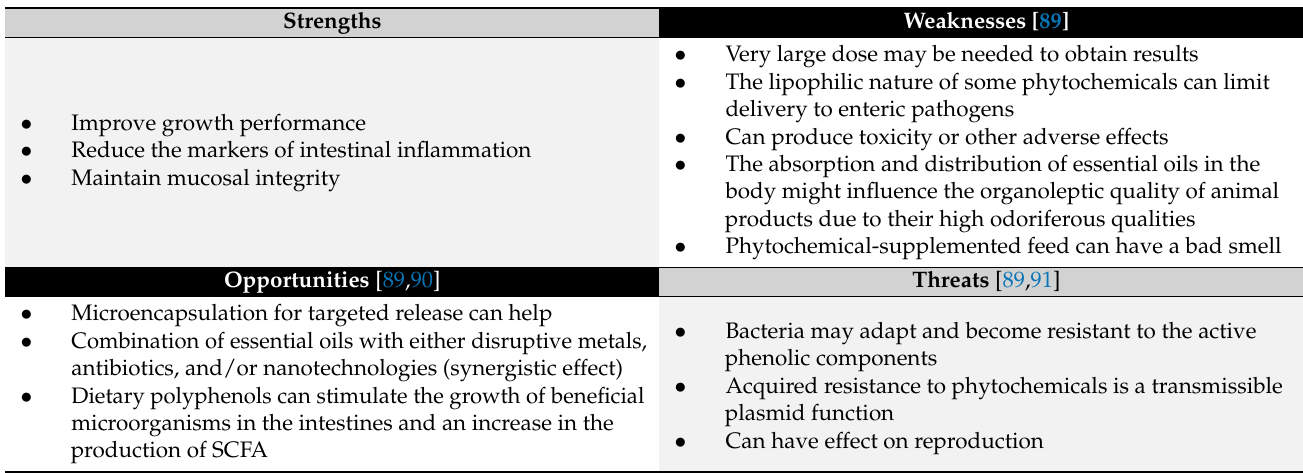
Table 2. SWOT analysis of